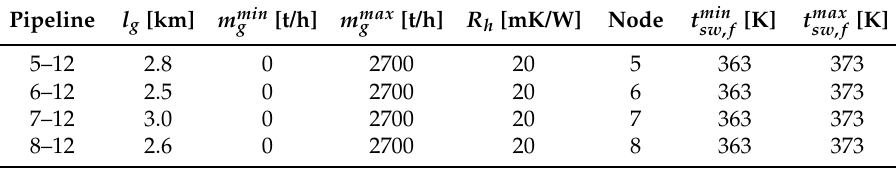
Table A6. The parameters of heating network nodes and